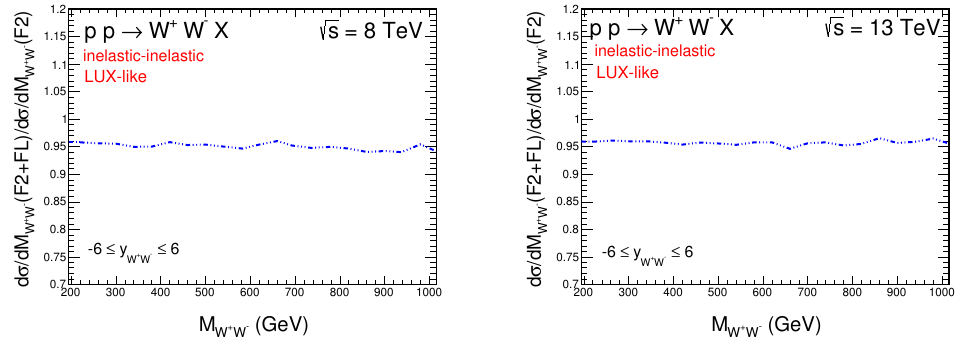
Figure 16 . The role of the longitudinal structure function as a function of W + W (cid:0) invariant mass. Shown is the ratio of the cross section with and without F L structure function in the unintegrated photon (cid:13)uxes. The calculation was performed for the LUX-like structure function. The left panel shows results for W = 8 TeV, while the right panel shows results for W = 13